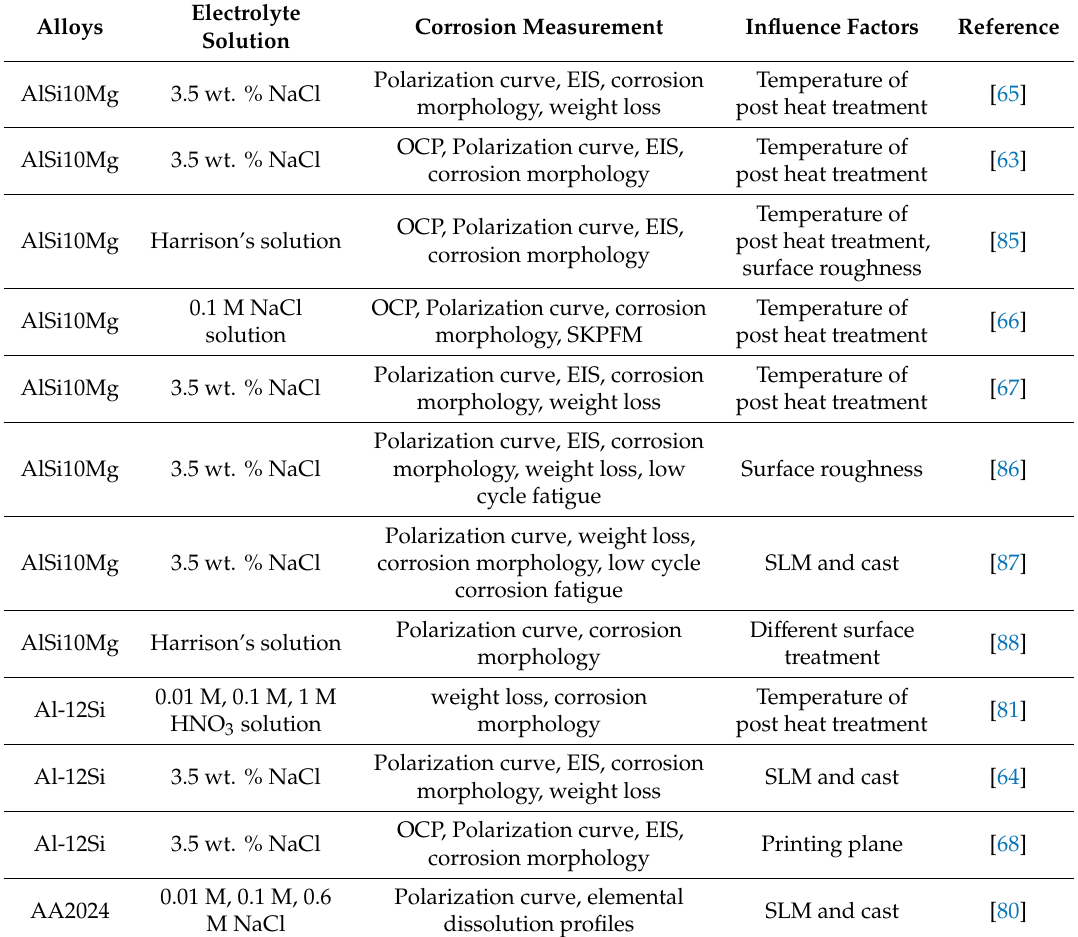
Table 1. Summary of the reported study on corrosion behaviors of SLM prepared aluminum alloys.